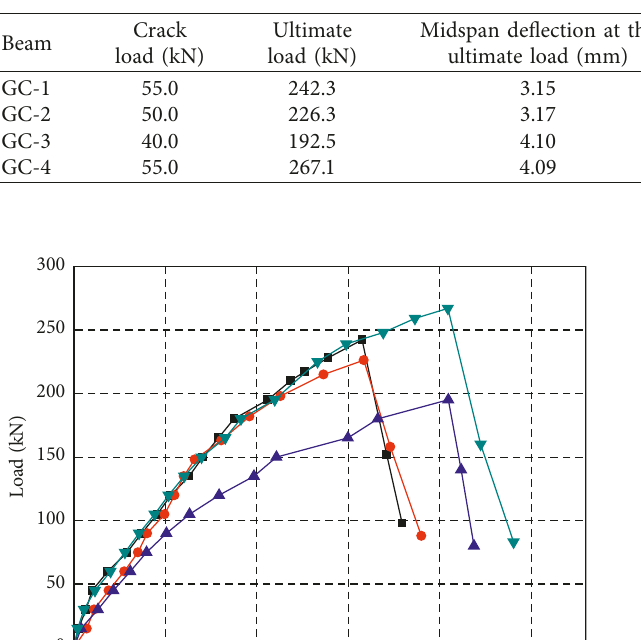
Table 3: Test data summary.